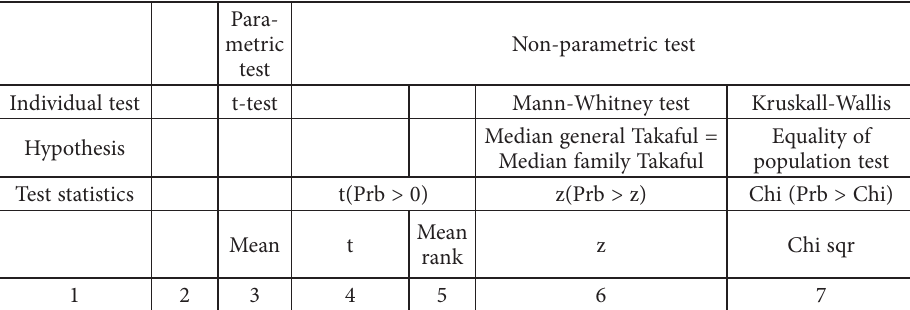
Table 3. Summary of parametric and non-parametric test